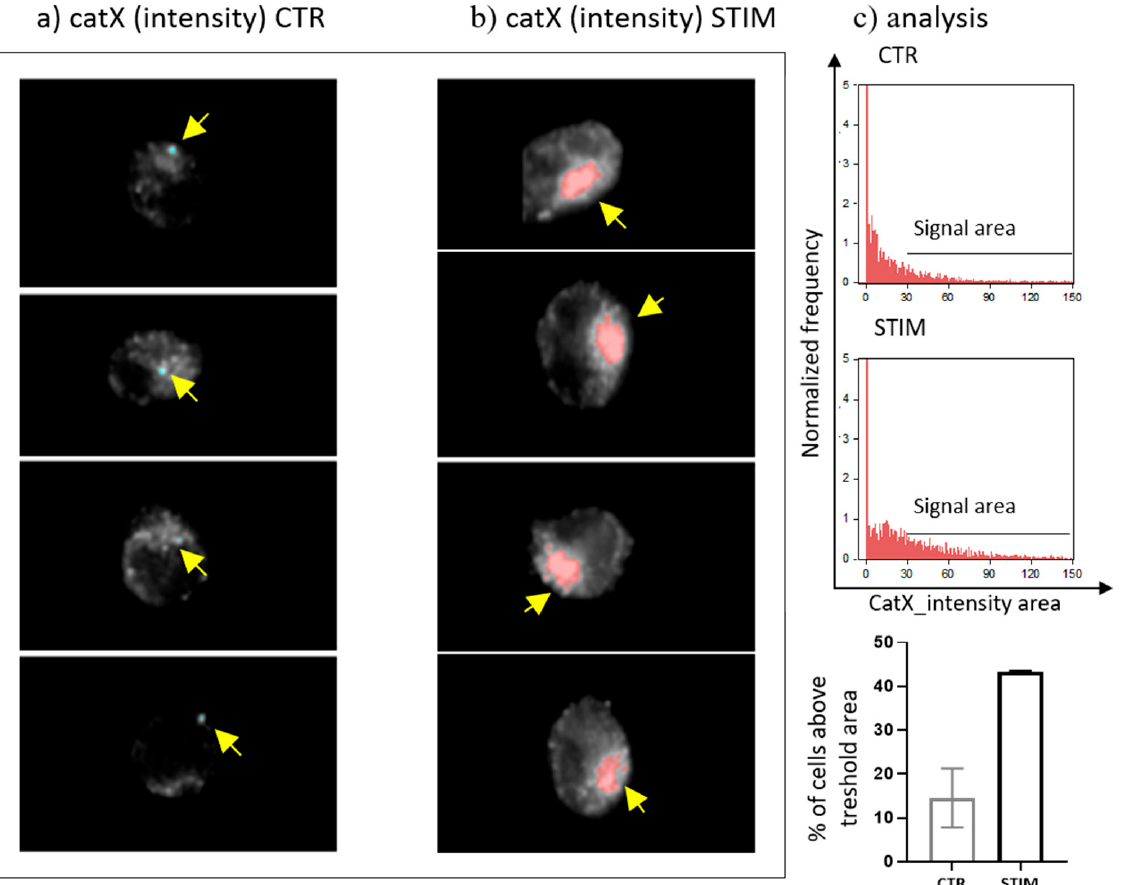
Figure 3. The localization of cathepsin X in NK-92 cells after PMA/IONO activation. NK-92 cells, ( a ) unstimulated (CTR) or ( b ) PMA/IONO stimulated (STIM), were stained for the imaging of intracellular cathepsin X expression by Amnis. ( c ) Post-imaging analysis in IDEAS software was used to quantify the cell area of high cathepsin X intensity. The images are representative of two independent experiments.